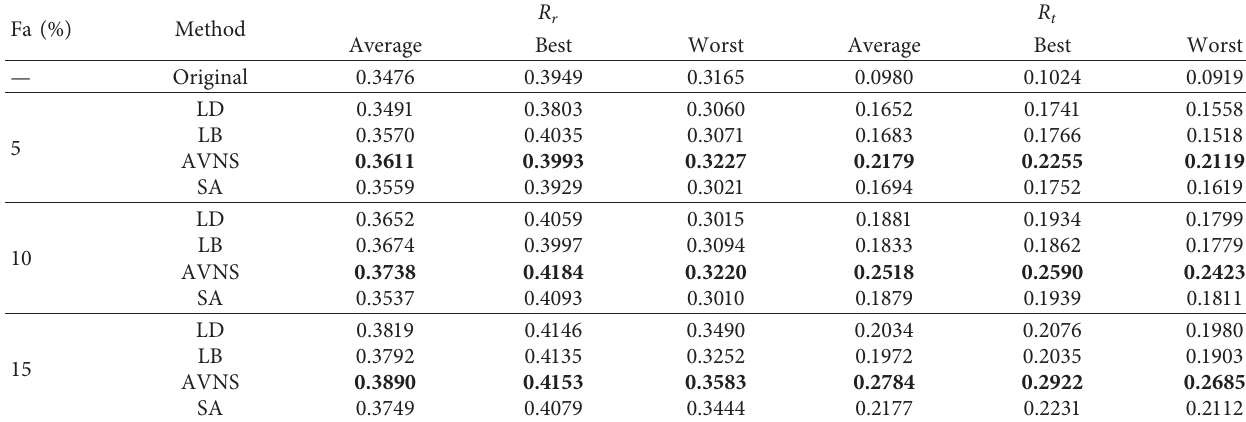
Table 3: Robustness comparison of chain 21 and reconfigured